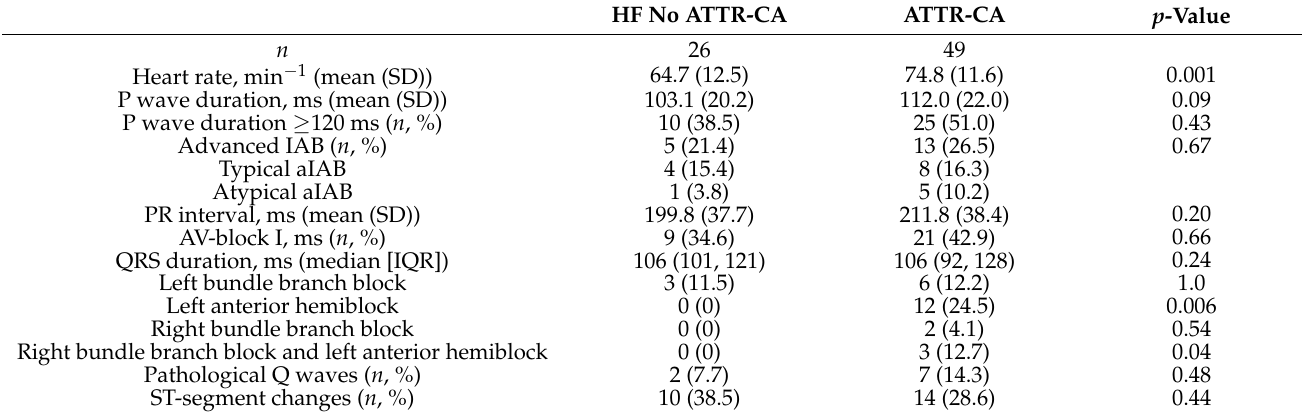
Table 2. ECG findings stratified by ATTR